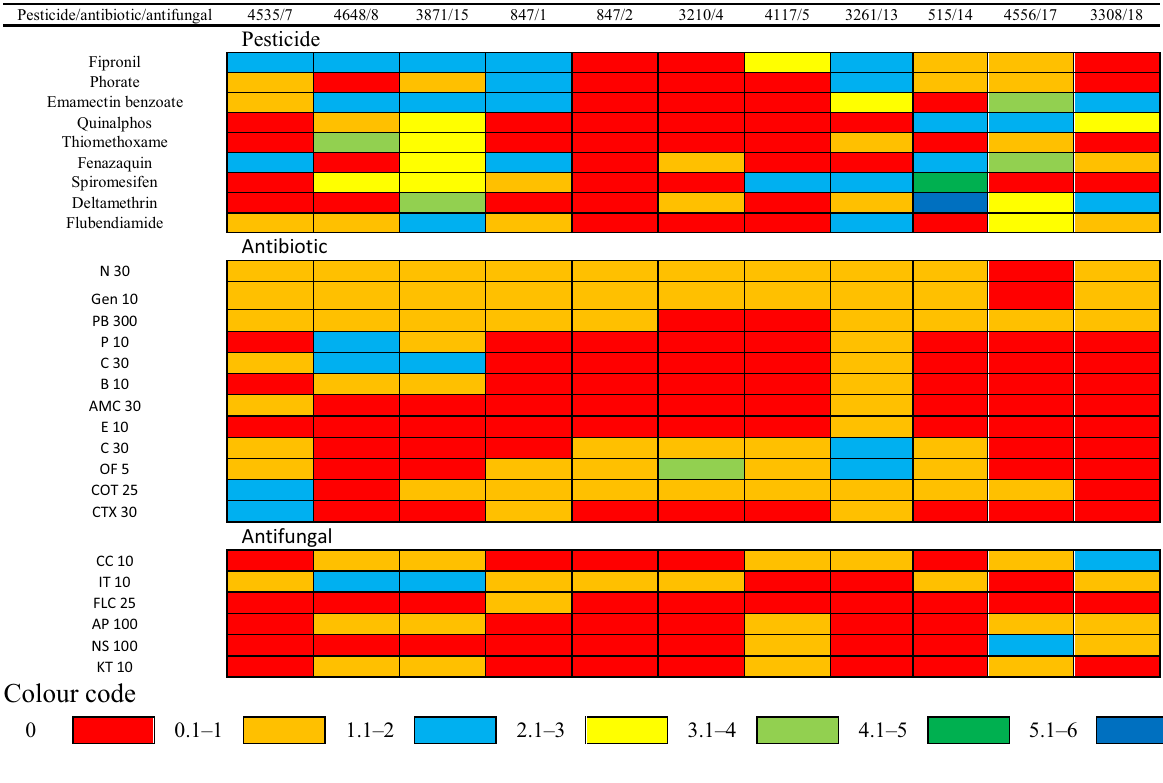
Table 2 Overall data of inhibition zone of our isolated PSMC Pesticide/antibiotic/antifungal